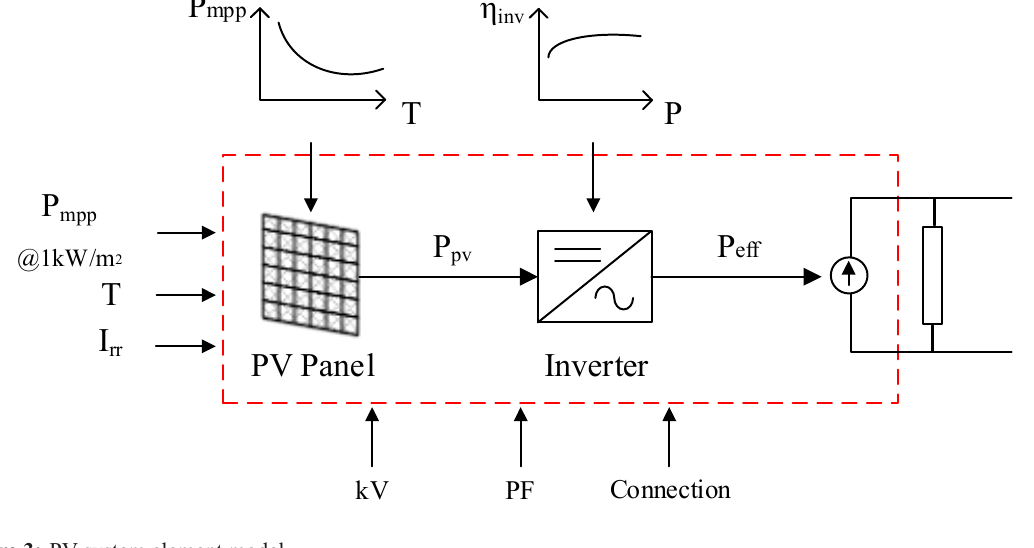
Figure 3: PV system element